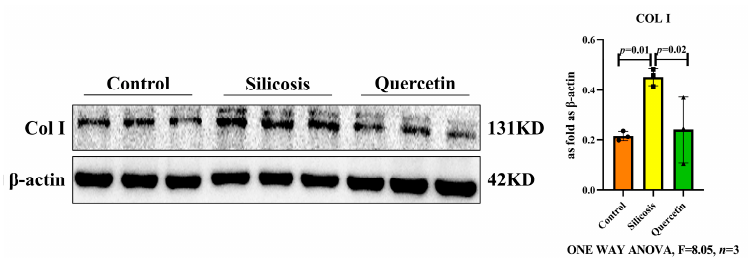
Figure 2. The expression of Col I in the lungs, measured by Western blot. Data are presented as the mean ± SD, n = 3 per group.